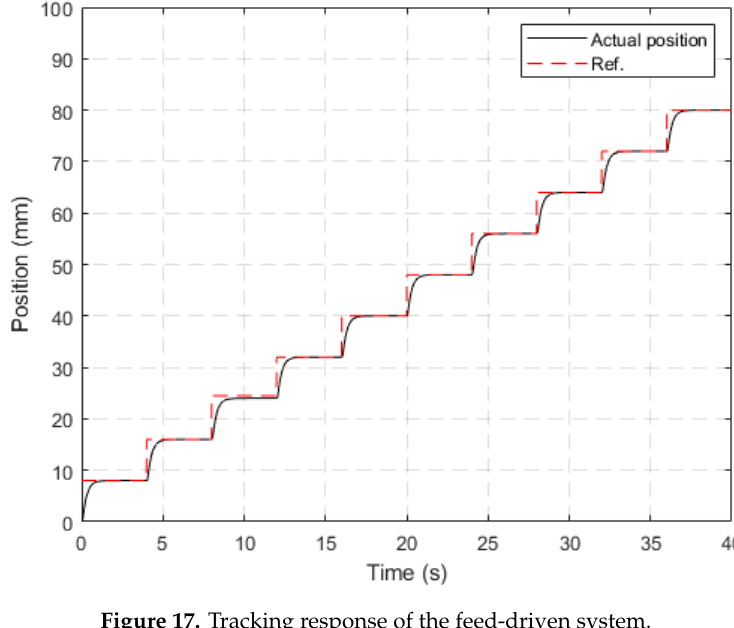
Figure 17. Tracking response of the feed-driven system.